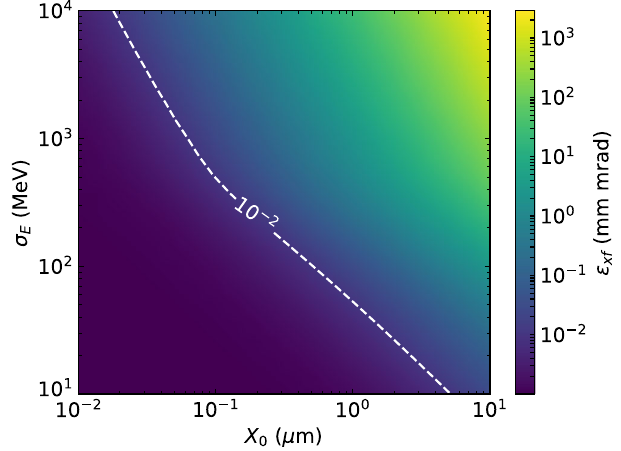
FIG. 12. Model projection for the final transverse emittance at the end of a 1 TeV collider with initial emittance ϵ x 0 ¼ 10 − 3 mm mrad as a function of the initial transverse offset and initial absolute energy spread. The initial beam width is 26 nm. Scaling laws presented in Ref. [2] were used, so that using L ¼ 1 m and a ¼ 1 sets all other parameters. The chain 0 stage contains 71 stages. The initial laser width verifies w ¼ λ p 0 . The initial beam energy is 10 GeV. The dashed line shows ϵ ¼ 10 − 2 mm mrad, which is considered as a reference value xf at the interaction point [39]. Figure 13 shows the counterpart of Fig. 12: The tolerance on misalignment is shown as a function of the LPA chain parameters (beam initial energy and length of each stage) for given beam parameters at the end of the